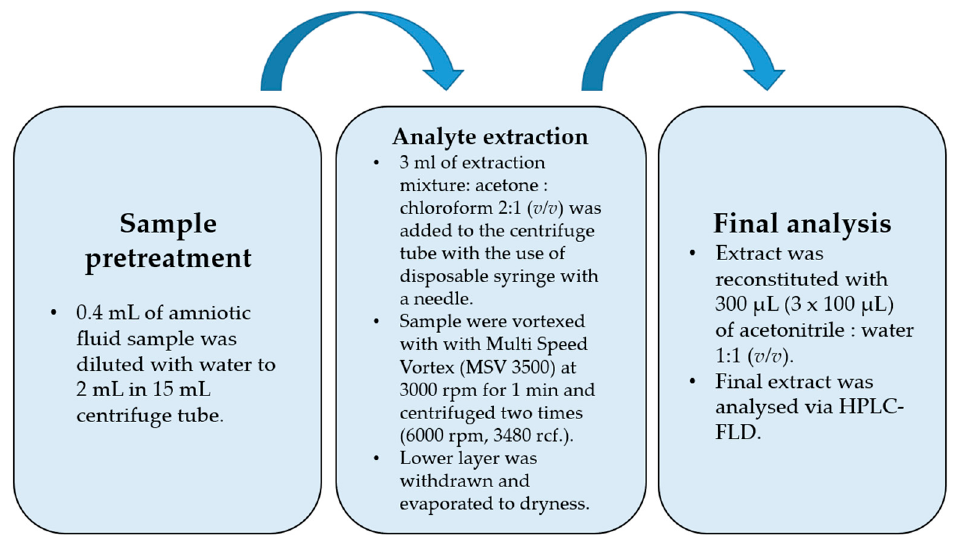
Figure 1. Flowchart of final optimized DLLME procedure. Table 2. Comparison of variants, recoveries, and relative standard deviations ( n = 6) obtained during preliminary